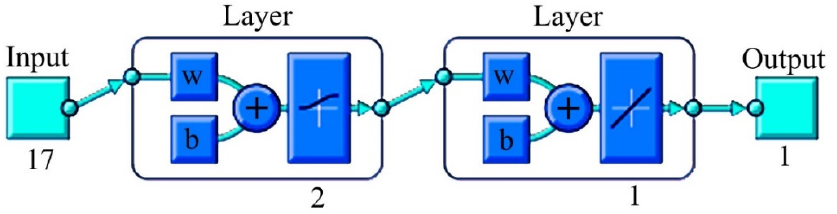
Figure 3. Schematic view of the BPNN structure used in this analysis. (Numbers are neurons in the layers, W: Weight, b: bias value, +: combination). Table 3. Factors of the copper occurrences in the Sahlabad mining area used as the input for the BPNN